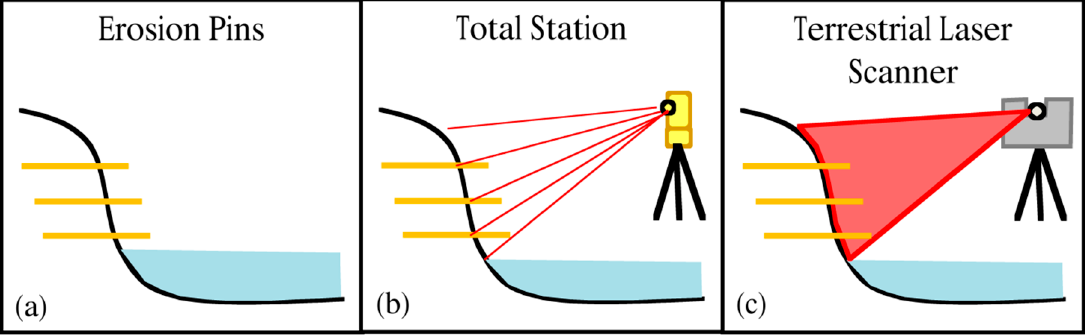
Figure 2. Deployment of ( a ) erosion pins, ( b ) total station, and ( c ) terrestrial laser scanner showing vertical profile of streambank.